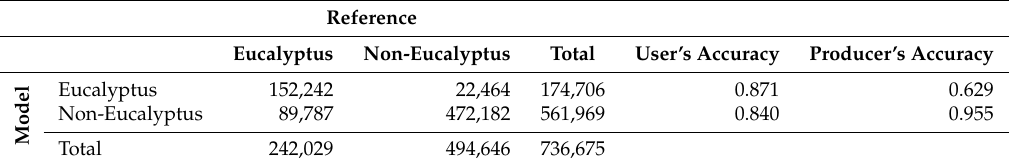
Table A3. Confusion Matrix for the model output at a threshold of 0.53 for Area (3).